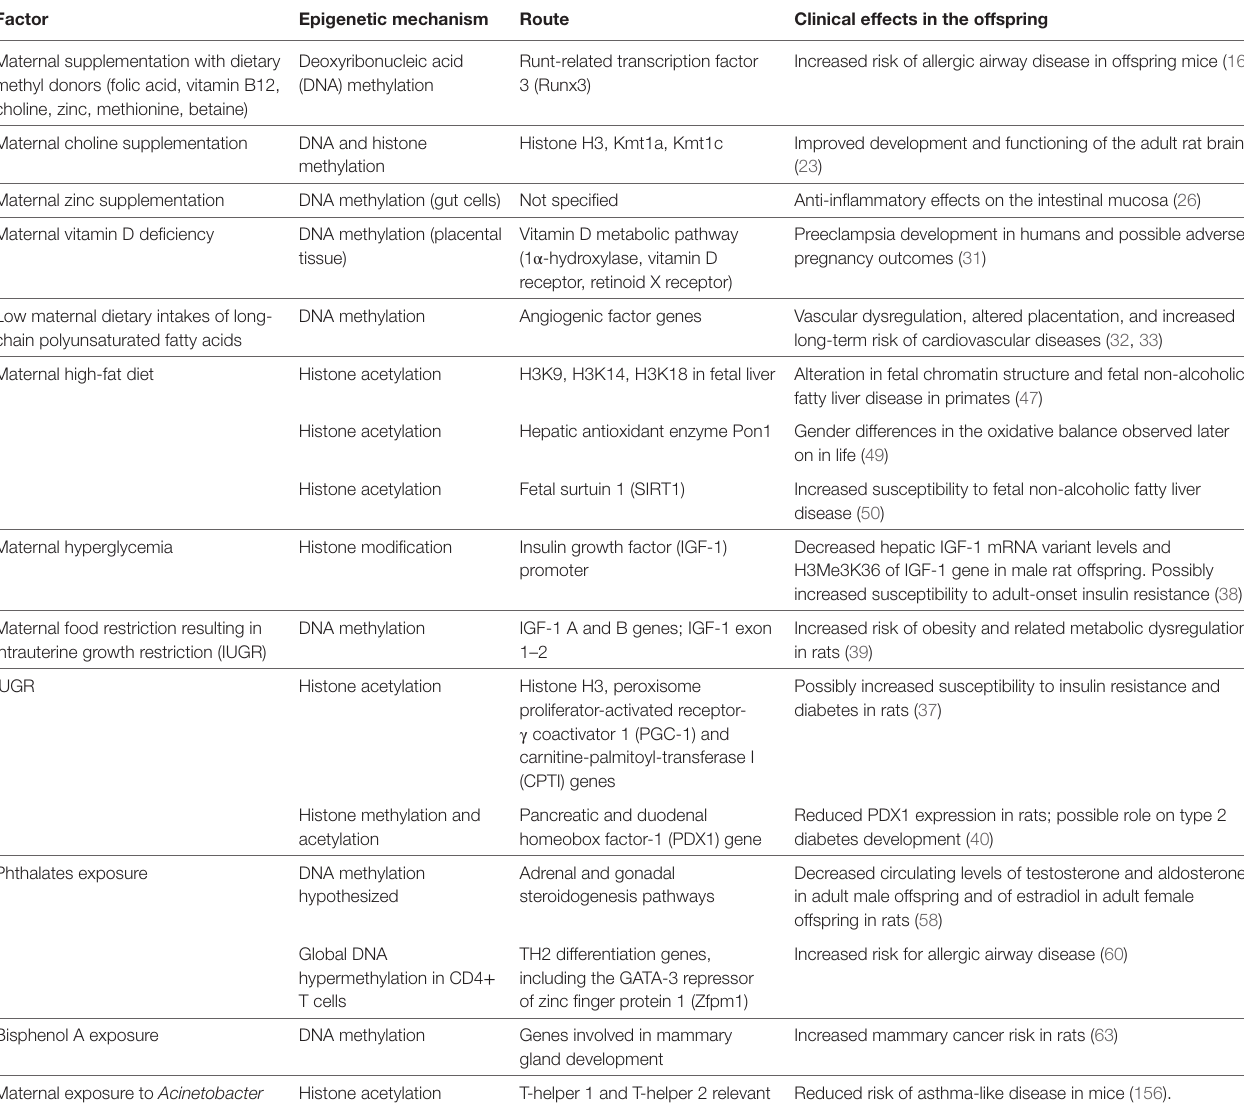
TABLe 1 | Main antenatal factors associated with epigenetic modifications in the